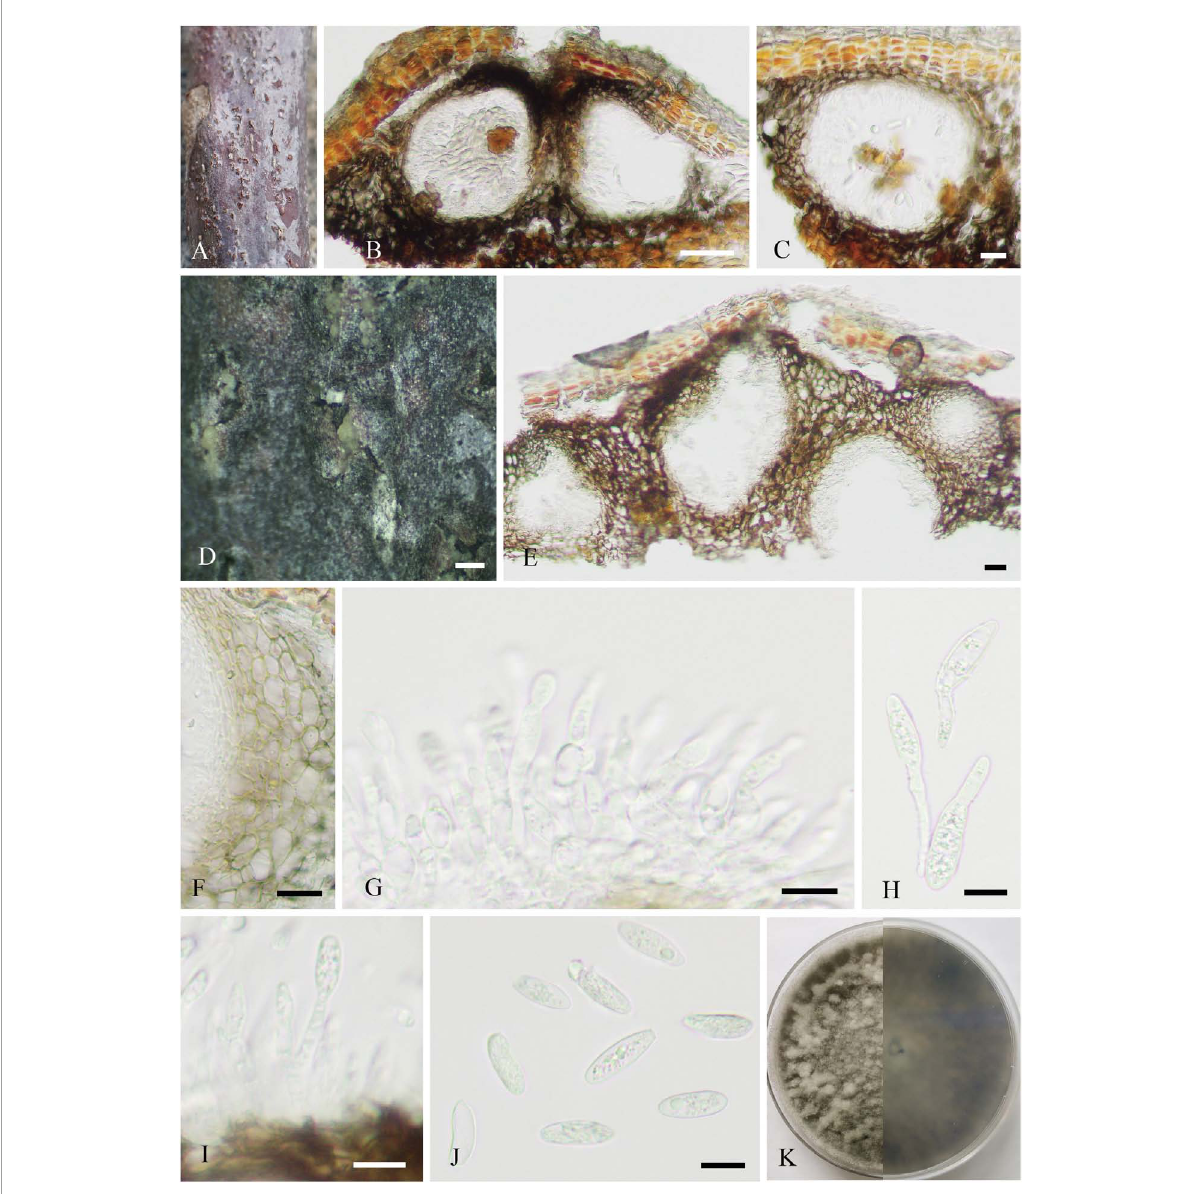
FIGURE7 Neofusicoccum sichuanense (SICAU 22-0094). (A) Pycnidia on dead twig. (B,C,E) Vertical section of pycnidia. (D) Pycnidia with conidia mass. (F) Pycnidial wall. (G,I) Conidiophores, conidiogenous cells, and conidia. (H) Germinating conidia. (J) Conidia. (K) Colony on PDA for 10 days. Scale bars: (B) 50 µ m, (C,E,F) 20 µ m, (D) 200 µ m, and (G–J) 10 µ m.